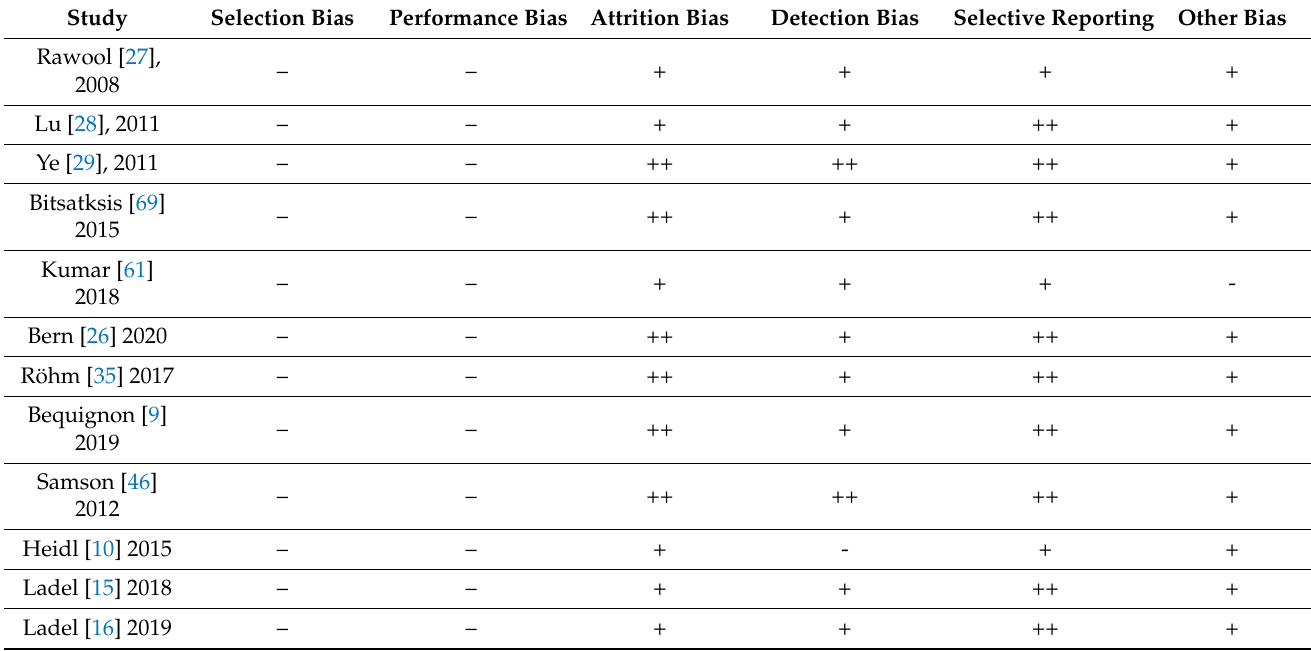
Table 2. Risk of bias summary using